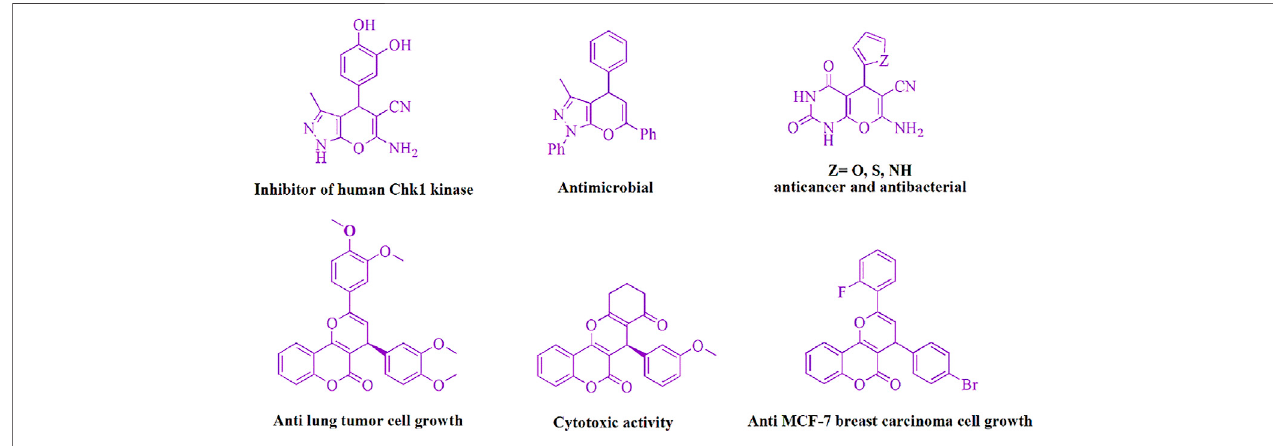
FIGURE 2 | Pyran motifs can be found in a variety of medicinally important compounds.